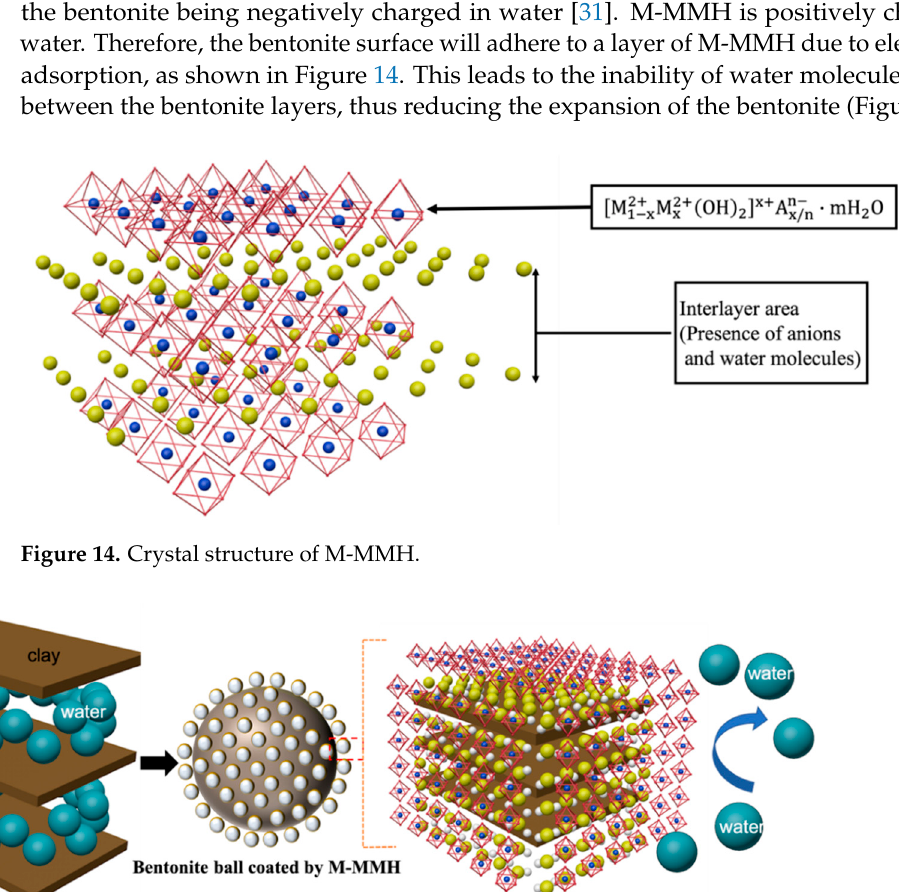
Figure 15. M-MMH inhibition mechanism.